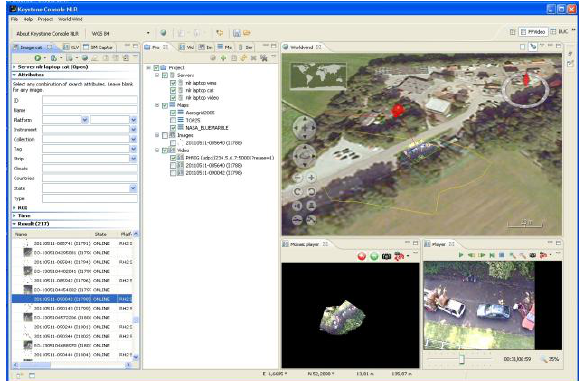
Figure 3. Keystone based Video Editor with database